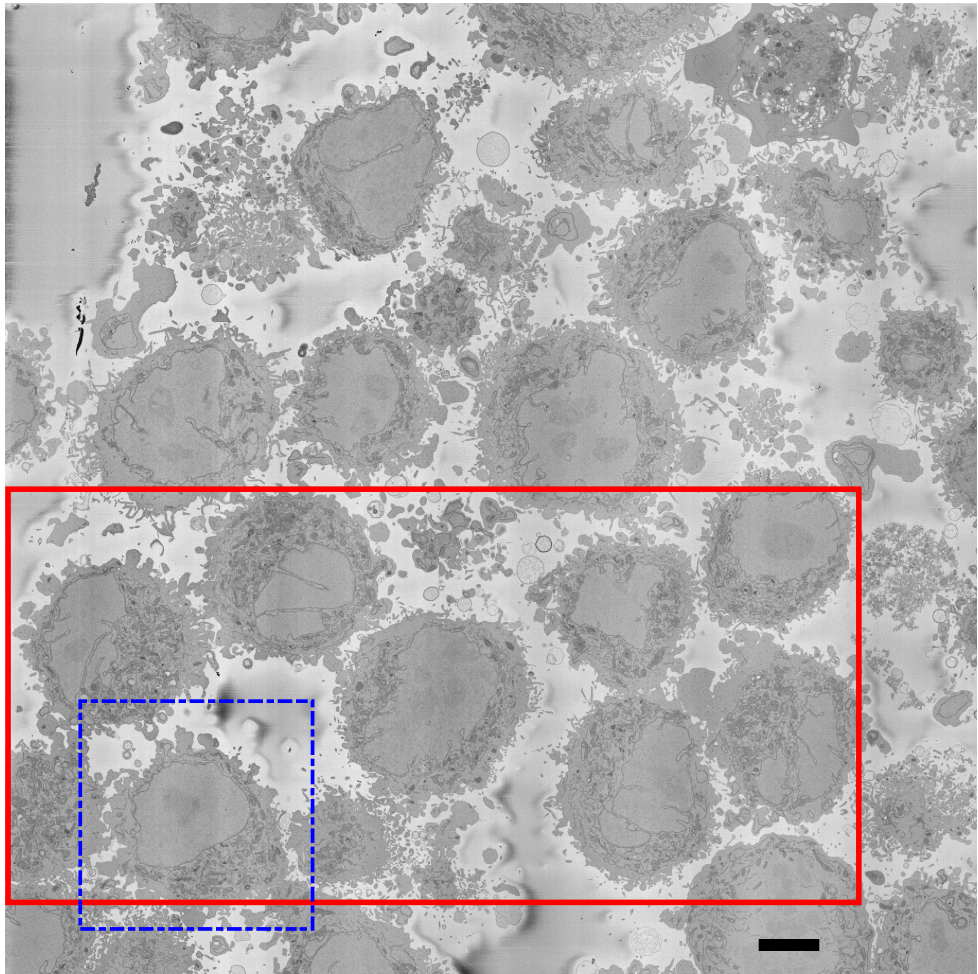
Figure 2. One representative slice of one of the 8192 × 8192 × 517 images. The image shows several HeLa cells which are darker than the background. It should be noticed that the background is not completely uniform in intensity but it is smooth, and changes of intensity are not as abrupt as those for the cells. The main visible characteristic of the cells is a large central region that corresponds to the nucleus, surrounded by a dark thin region corresponding to the nuclear envelope. Cells with different characteristics are visible: for some, the nucleus is relatively smooth and regular (dashed blue box; this will be referred to in the manuscript as the region of interest (ROI)) as opposed to other nuclei that present invaginations and more complex geometries. Other structures, such as mitochondria are visible, but these are outside the scope of this work. A solid red box shows a larger region of interest, which will be used for qualitative comparisons. Scale bar at the bottom right indicates 5 µ